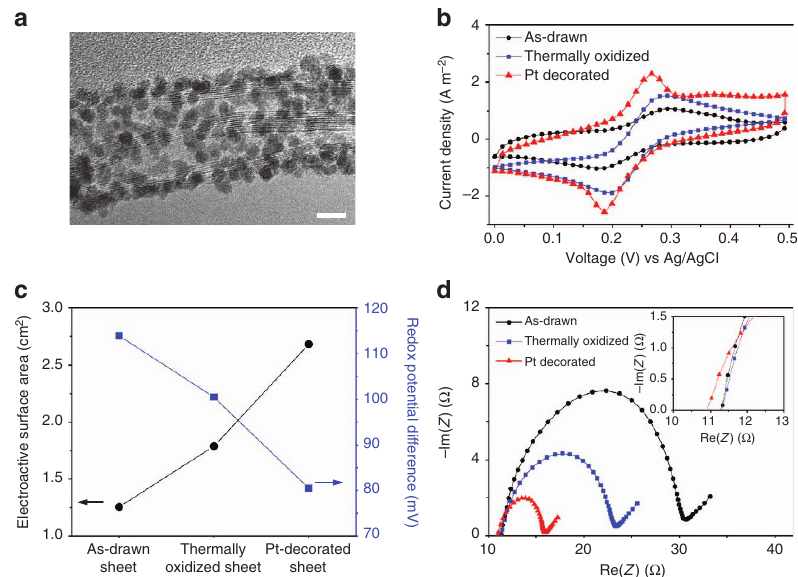
Figure 4 | Pt nanoparticle deposition for improving electrode performance. ( a ) HR-TEM image of individual CNT decorated by Pt nanoparticles. Scale bar, 5nm. ( b ) Cyclic voltammograms obtained at a 100mVs (cid:2) 1 scan rate using as-drawn, thermally oxidized, and thermally oxidized and Pt-deposited CNT electrodes. ( c ) Electroactive surface area and redox potential difference for the above various CNT electrodes. ( d ) Nyquist impedance plots for various electrodes. The inset shows a close-up of the high frequency region of the